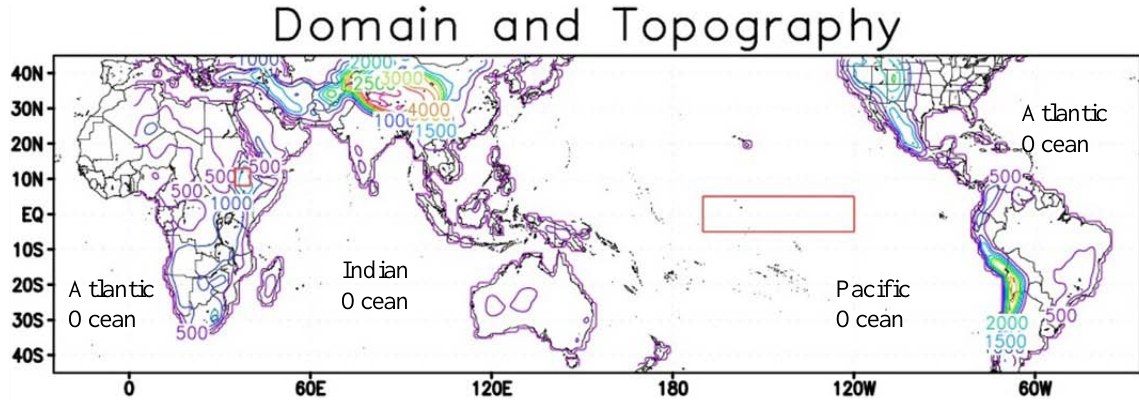
Figure 1. The domain and the topography of the model. The red box in the Pacific Ocean shows the Niño 3.4 region, while the red box in